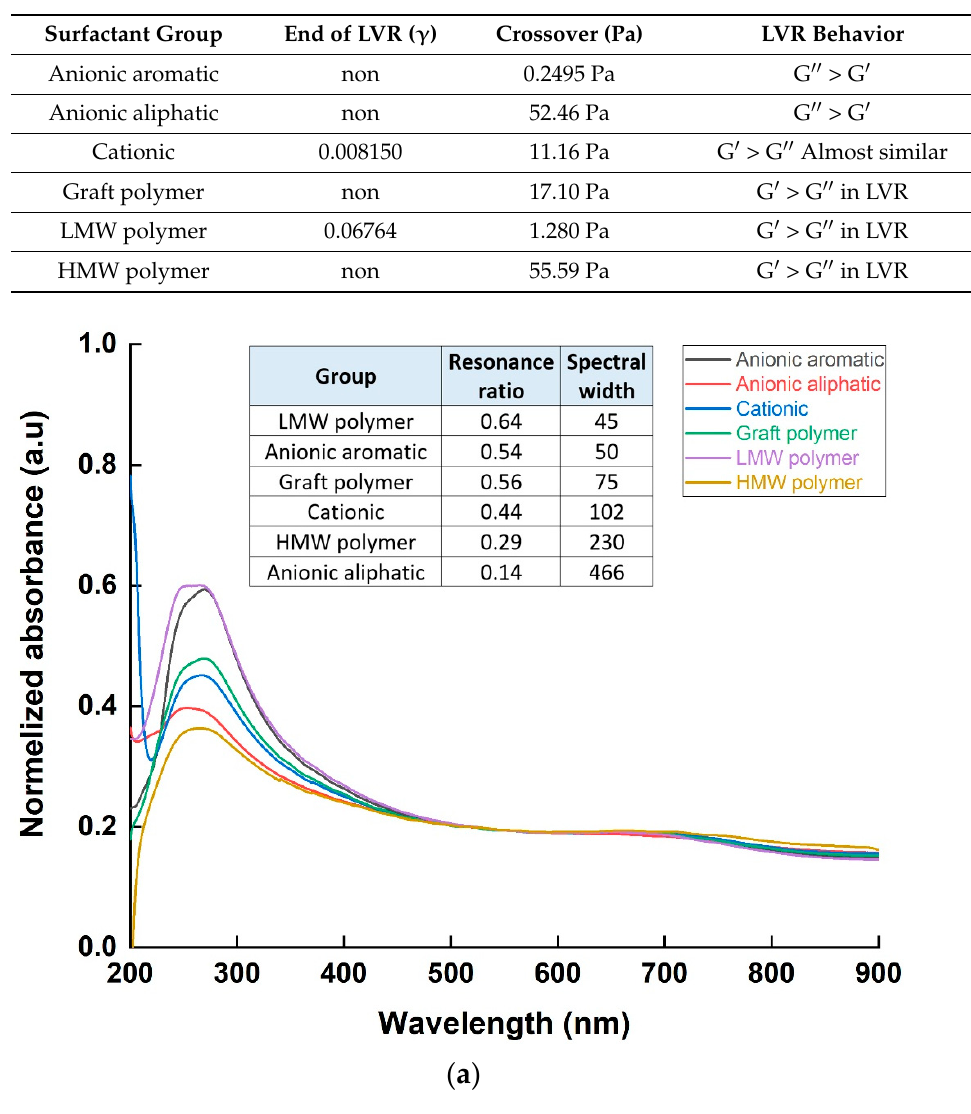
Table 3. LVR values and crossover point (Pa) for SWCNT suspensions dispersed in various surfactants.